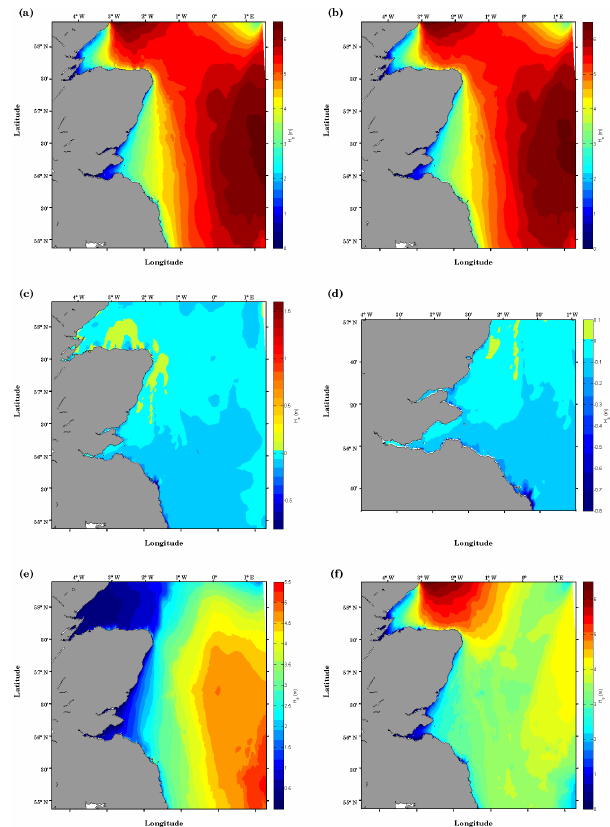
Figure 18. The modelled H s on the east coast of Scotland at 16:00UTC on 19 June 2010: (a) coupled model (mean WCI in- cluded), (b) uncoupled model (mean WCI not included), (c) dif- ference between coupled and uncoupled models, (d) difference be- tween coupled and uncoupled models in the Firth of Forth area, (e) windsea waves, (f) swell